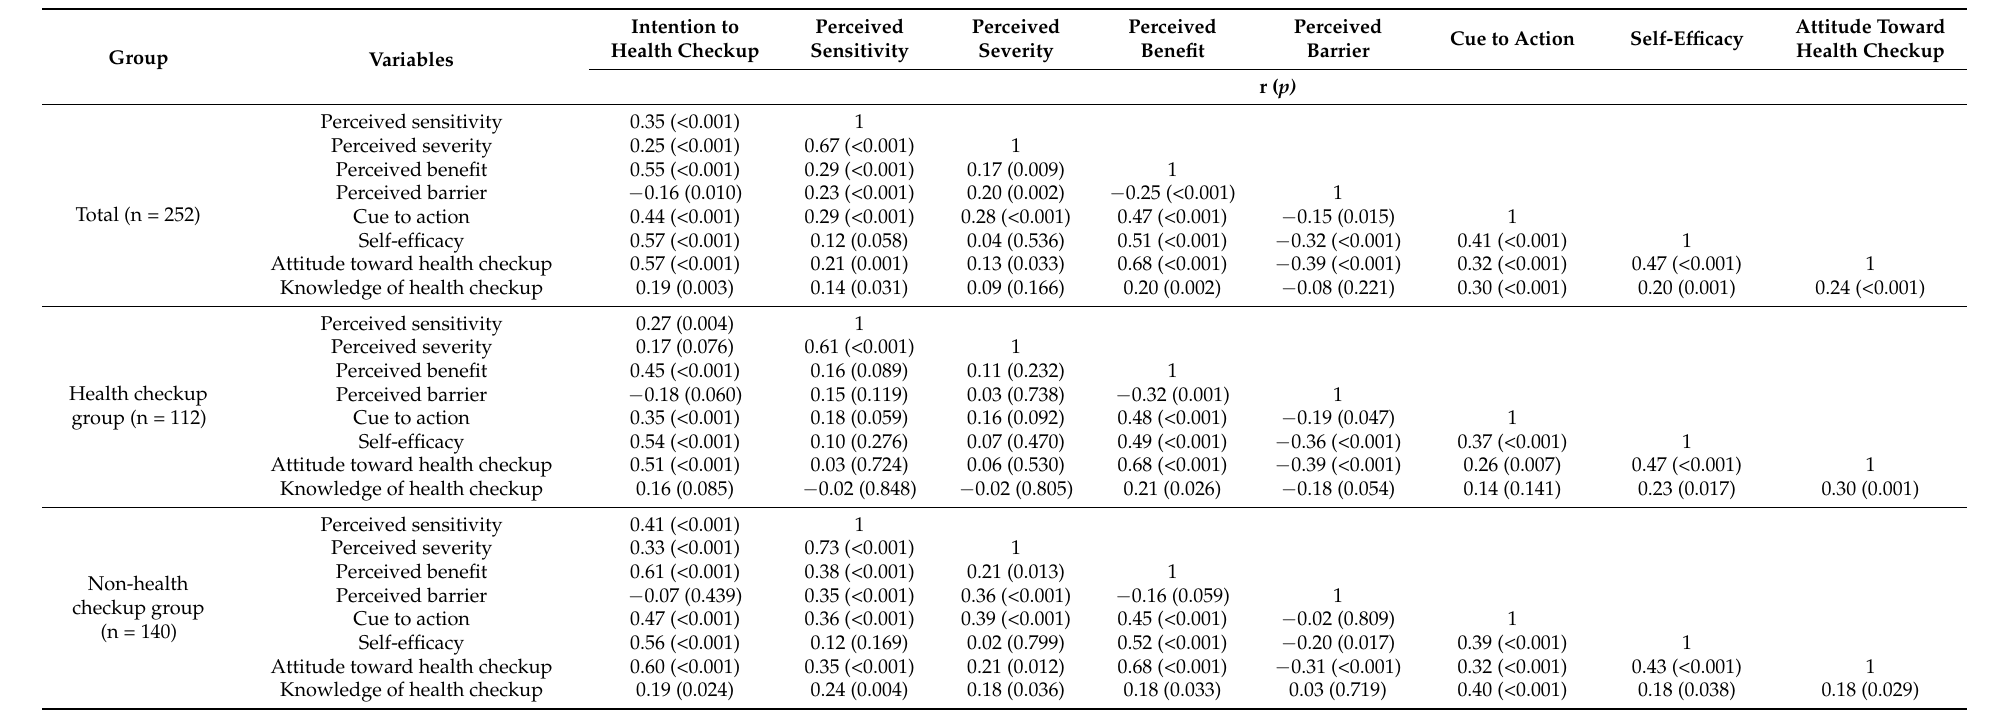
Table 4. Correlation among the variables (n =